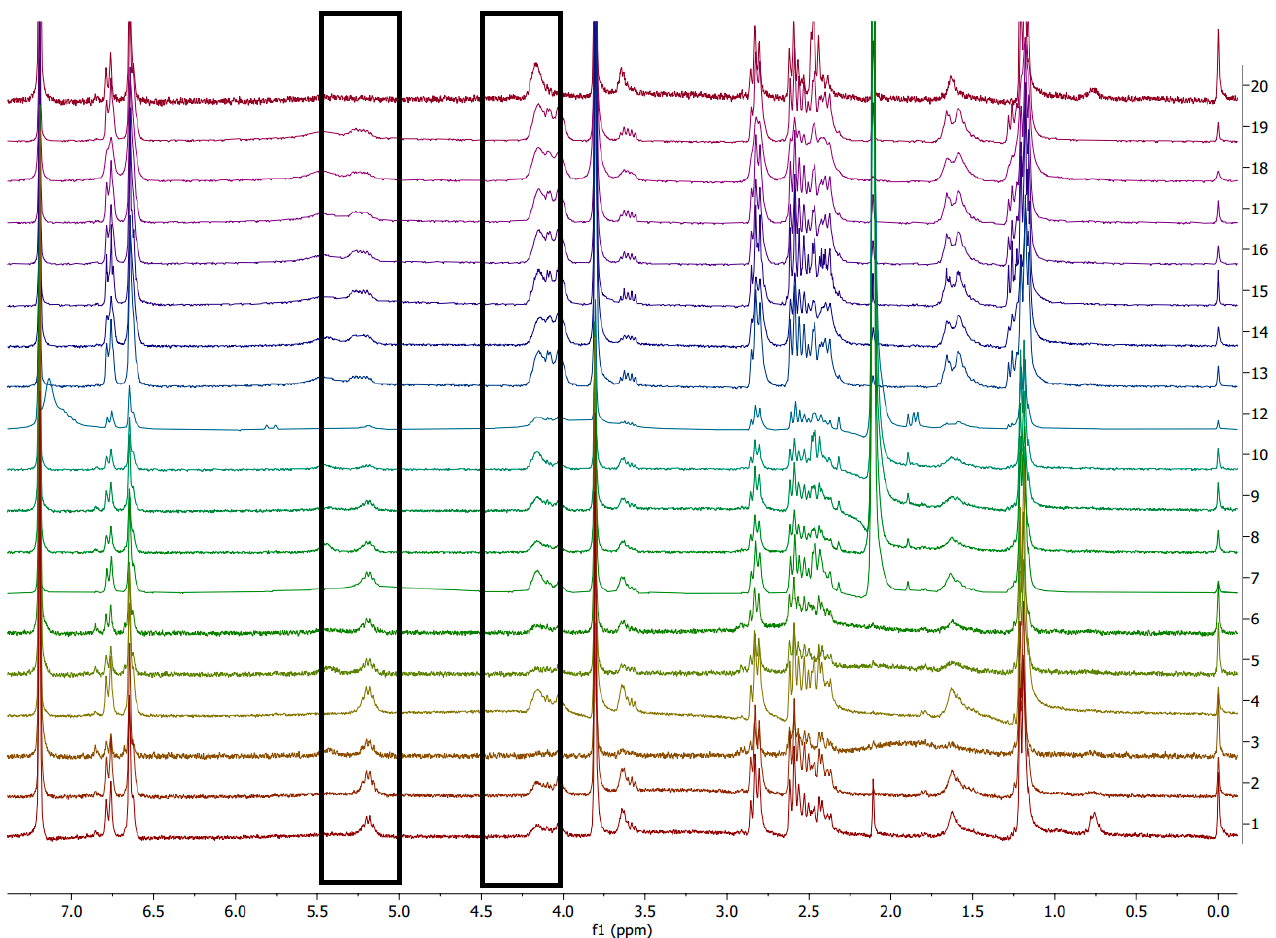
Figure 4. 1 H NMR (CDCl 3 ) spectrum of specimen PHB/BDF 40 w% during alkali degradation with NaOH solution (0.25 M), spectrum 1 corresponds to t 0 ; up to spectrum 19, samples were taken every 30 min of reaction; spectrum 20 corresponds to 32 h reaction.